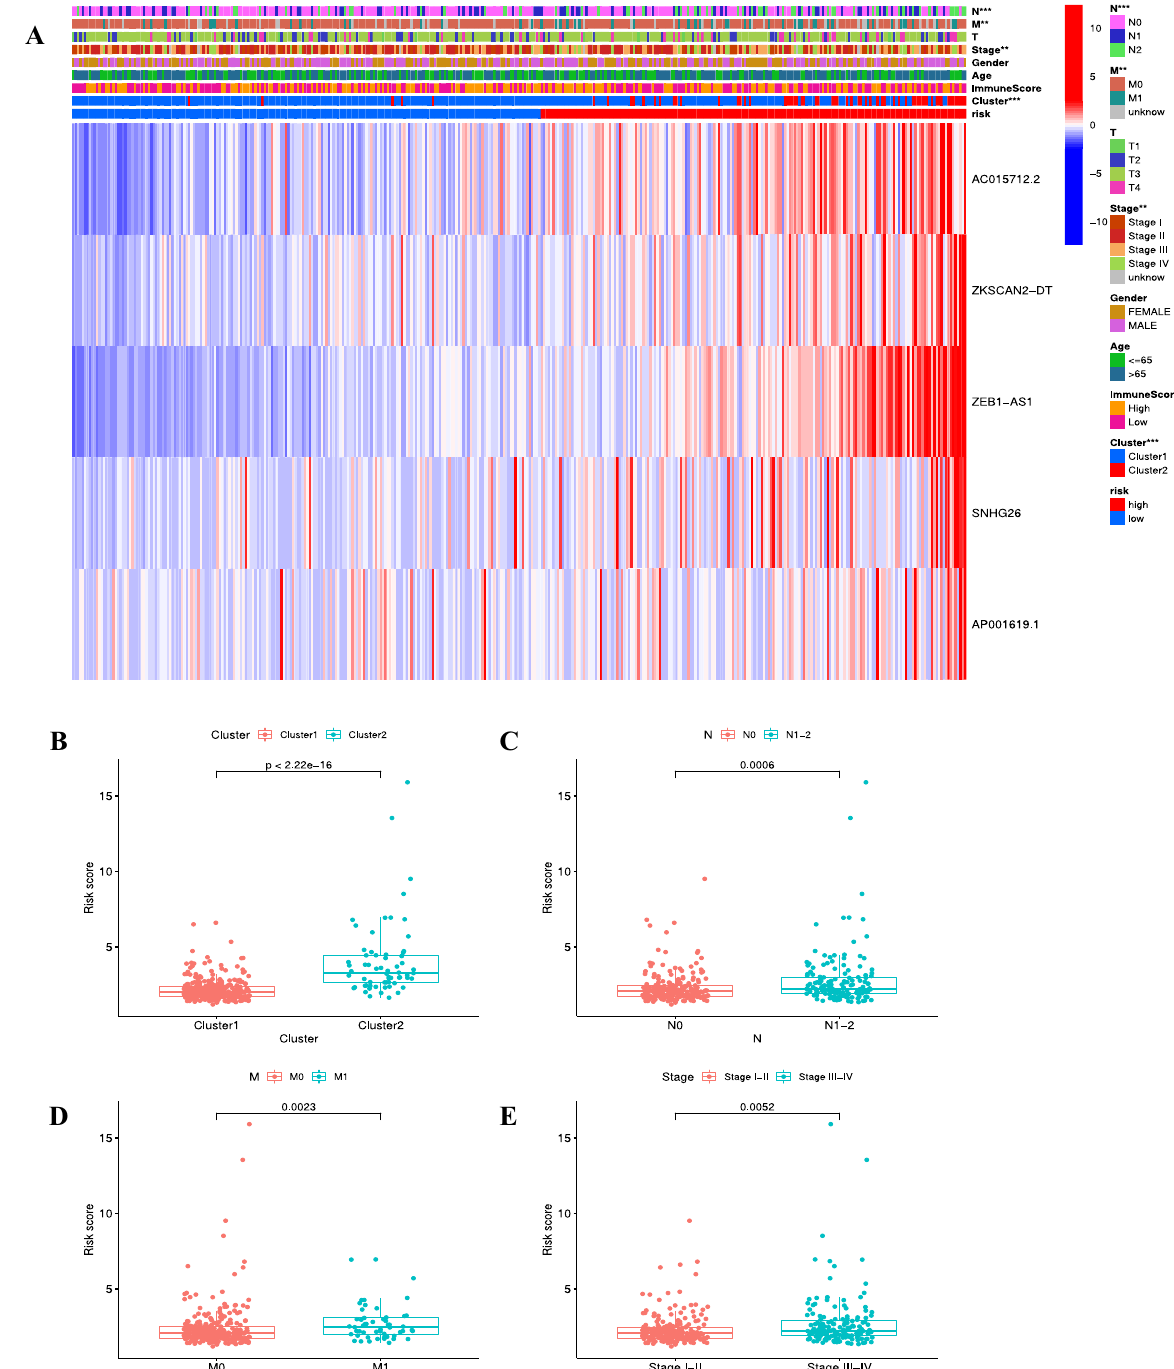
Figure 9. Correlation between prognostic signature and clinical characteristics. ( A ) The heatmap for the distribution clinical characteristics in different risk groups. ( B – E ) The histogram for distribution of risk score with significant difference stratified by cluster ( B ), pathological N stage ( C ), pathological M stage ( D ), and tumor stage ( E ). ** p < 0.01, and *** p <